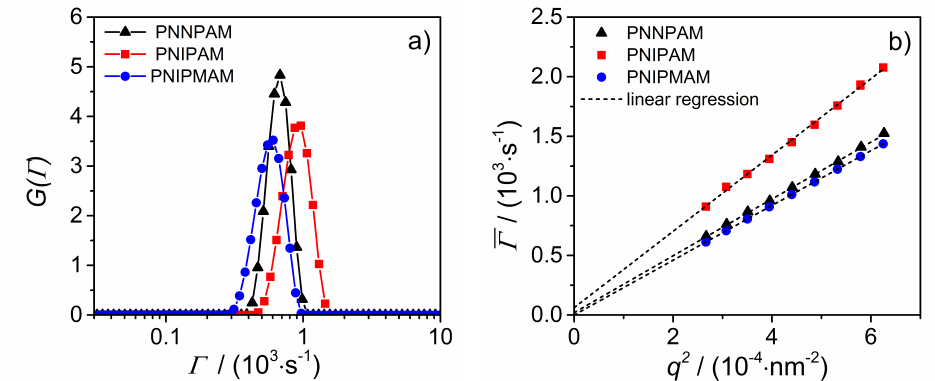
Figure 7. ( a ) PCS relaxation rate distribution of the collapsed homopolymer microgels; ( b ) Plot of the mean relaxation rate Γ vs. q 2 and the corresponding linear regression to determine the translational diffusion coefficient D T